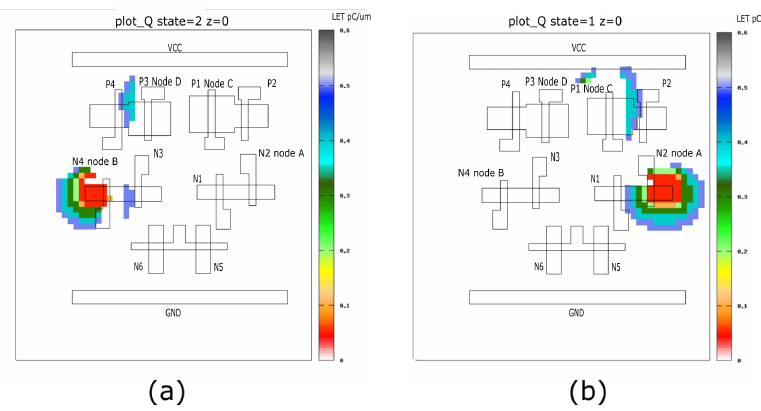
Figure 11. ( a ) TFIT simulation sensitive area with all ‘0’ stored data pattern ( b ) TFIT simulation sensitive area with all ‘1’ stored data